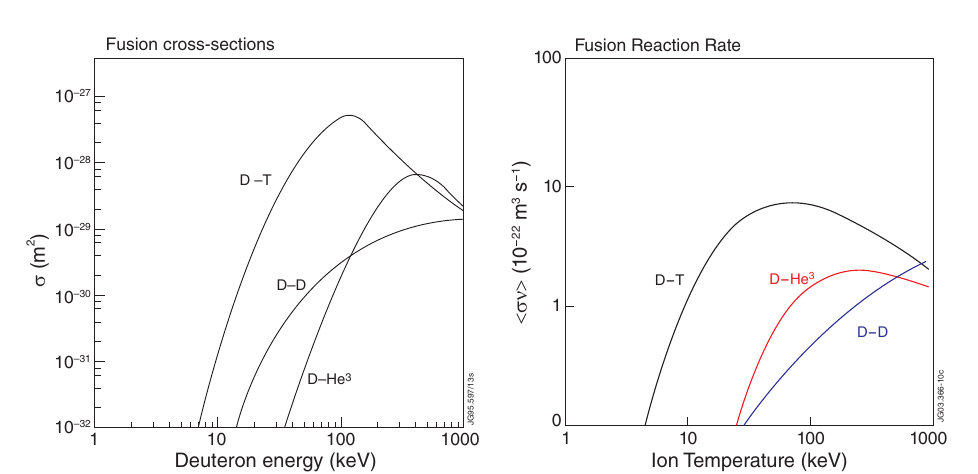
Fig. 1. – Fusion cross sections and fusion reactivity for the three main fusion reactions. The cross section is plotted as a function of the energy of the deuteron impinging on the target at